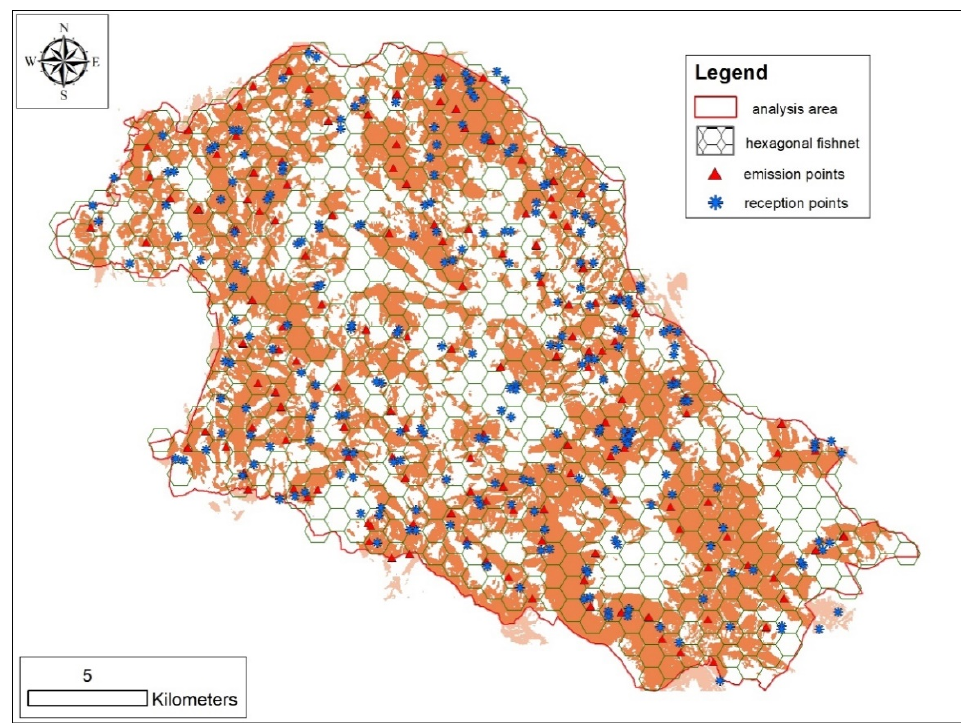
Figure 3. Map of the 0.78 km 2 hexagonal meshes selected as availability sample, showing the distribution of emission (red triangles) and listening (blue asterisk) sites. Light brown polygons represent the resulting effective sampled areas based on audibility analysis.